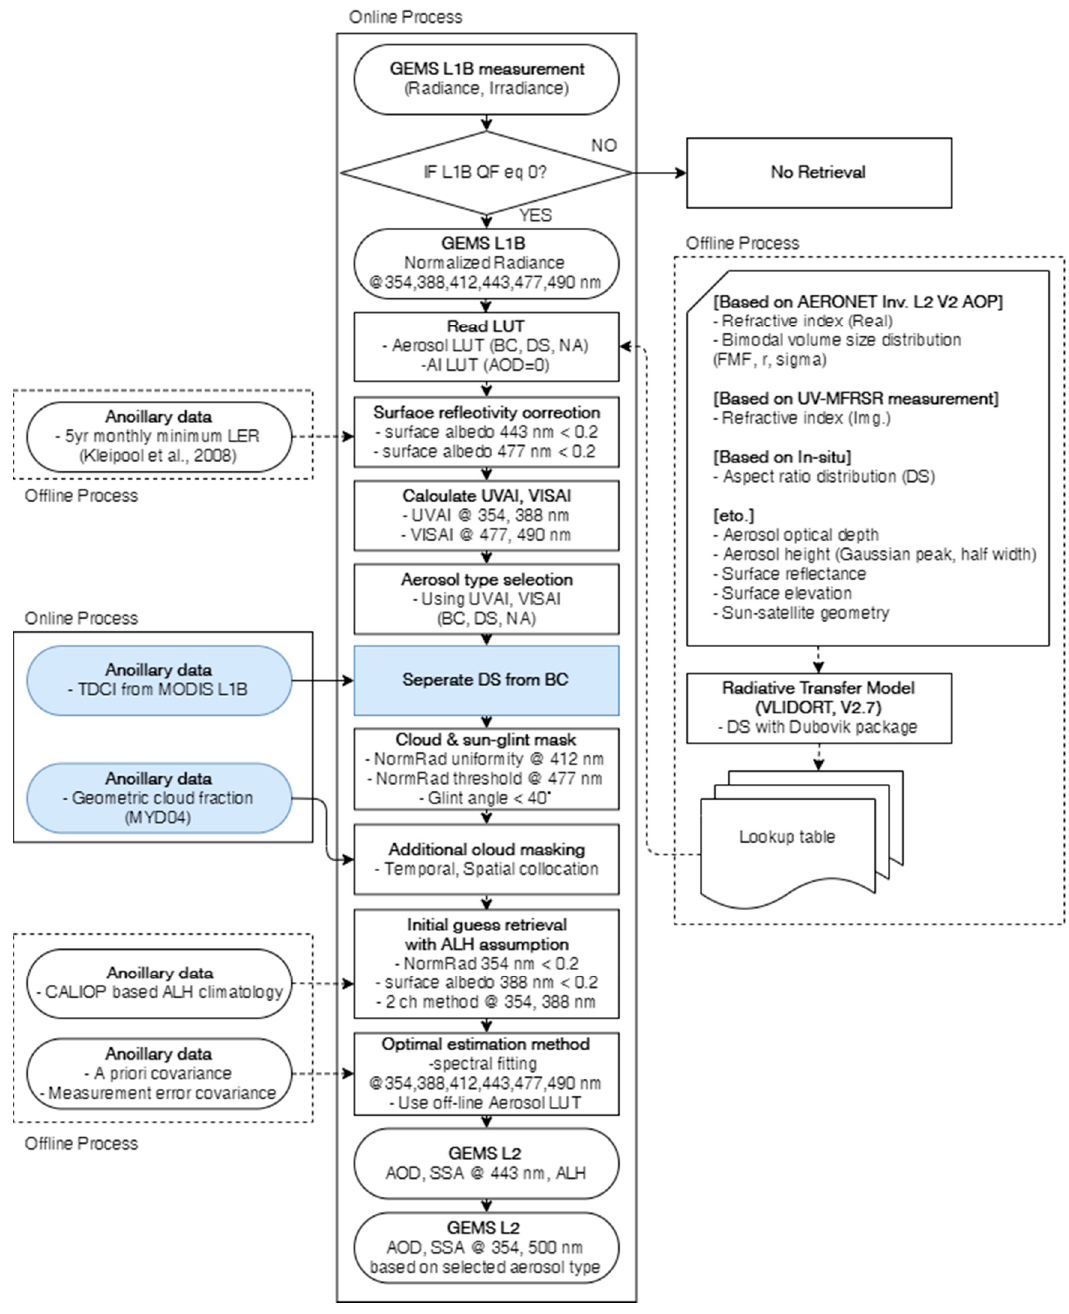
Figure 1. Flowchart describing synergistic use of meteorological imager for GEMS aerosol algorithm improvement. The unshaded components correspond to the GEMS aerosol algorithm [33,37]. The figure is modified from Figure 1 of Go et al. [33]. Blue shading indicates synergistic use of meteorological instruments.